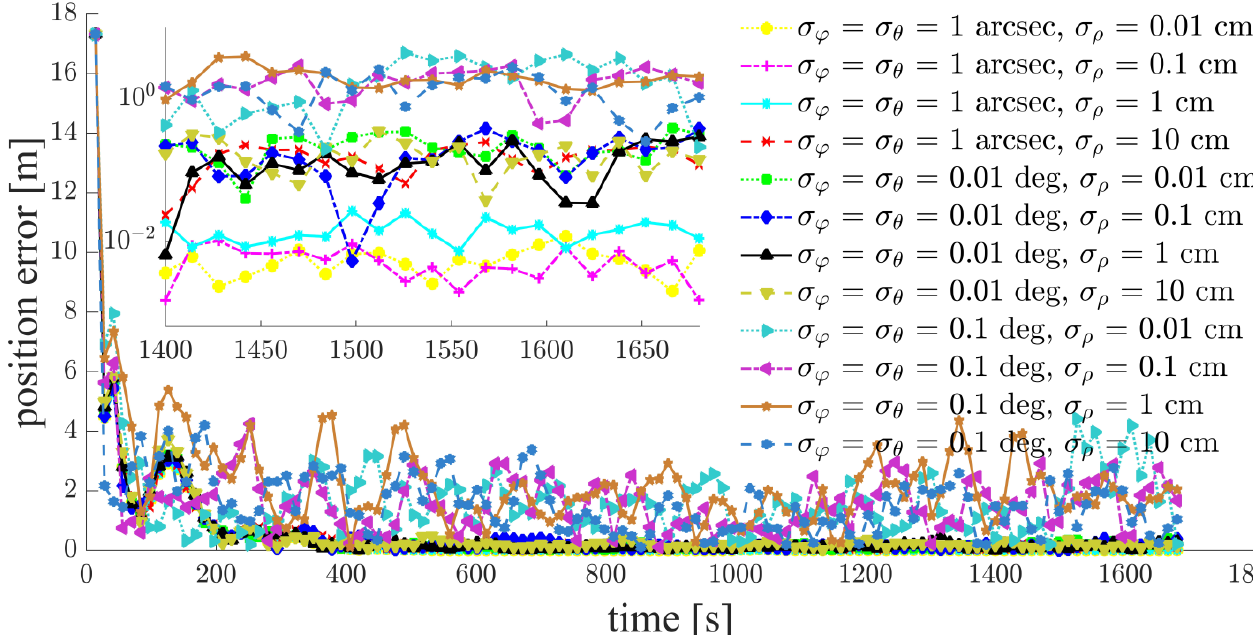
Figure 11. Relative navigation errors of 𝑆 1 (simulated scenario: Case d, space-circle formation radius of 1 km).